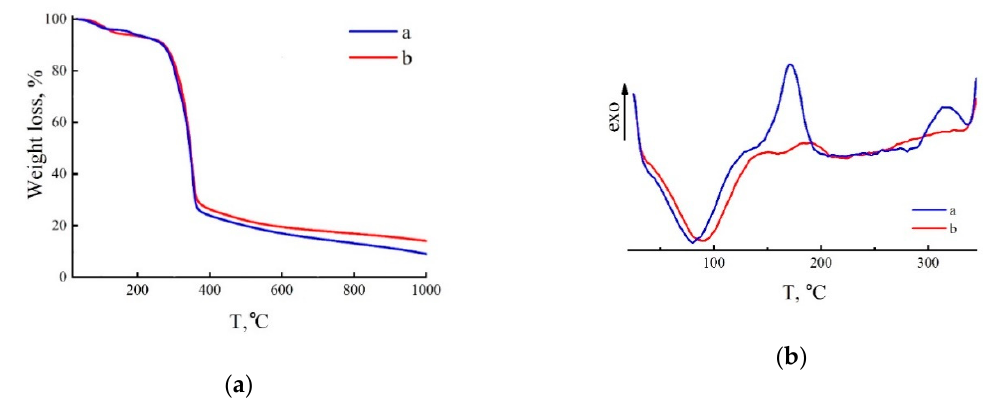
Figure 8. TGA ( a ) and DSC ( b ) curves of fibers coagulated in IBA at 25 °C (a) and 70 °C (b), washing in alcohol and drying.